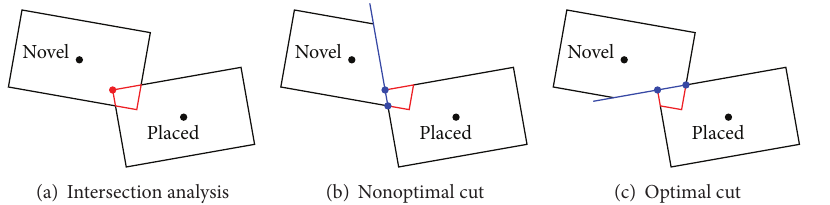
Figure 4: Subtractive cut. If both cuts satisfy the aforementioned constraints, cut (c) is chosen. In this way, a smaller area is removed from the novel tile.